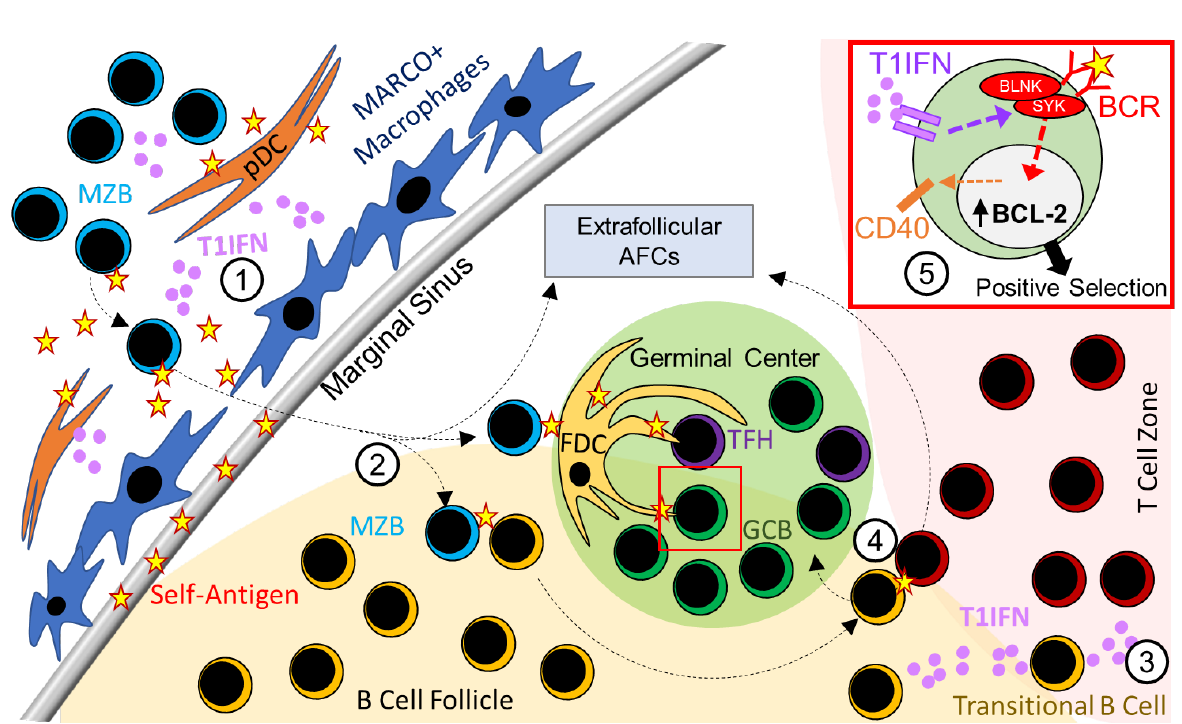
Figure 1. Type 1 interferon (T1IFN) signaling promotes autoreactive B cell generation in the extrafollicular AFC and follicular GC pathways. (1) T1IFN is predominantly produced by activated plasmacytoid dendritic cells (pDCs) at the splenic marginal zone. (2) Elevated T1IFN promotes the removal of MARCO1+ macrophages and allows for the migration of marginal zone B cells (MZBs) that carry self-antigen to the B cell follicle to activate self-reactive B cells. (3) Transitional B cells in the T cell zone can also produce T1IFN to further activate naïve B cells and T cells. (4) After acquiring self-antigens from MZBs, activated follicular B cells interact with cognate T cells, and differentiate into extrafollicular antibody-forming cells (AFCs) or mature through germinal centers. (5) Within the germinal center, T1IFN signaling in GC B cells augments BCR signaling, and promotes proliferation, CD40 expression, and BCL-2 expression to promote the survival and positive selection of self-reactive B cells.